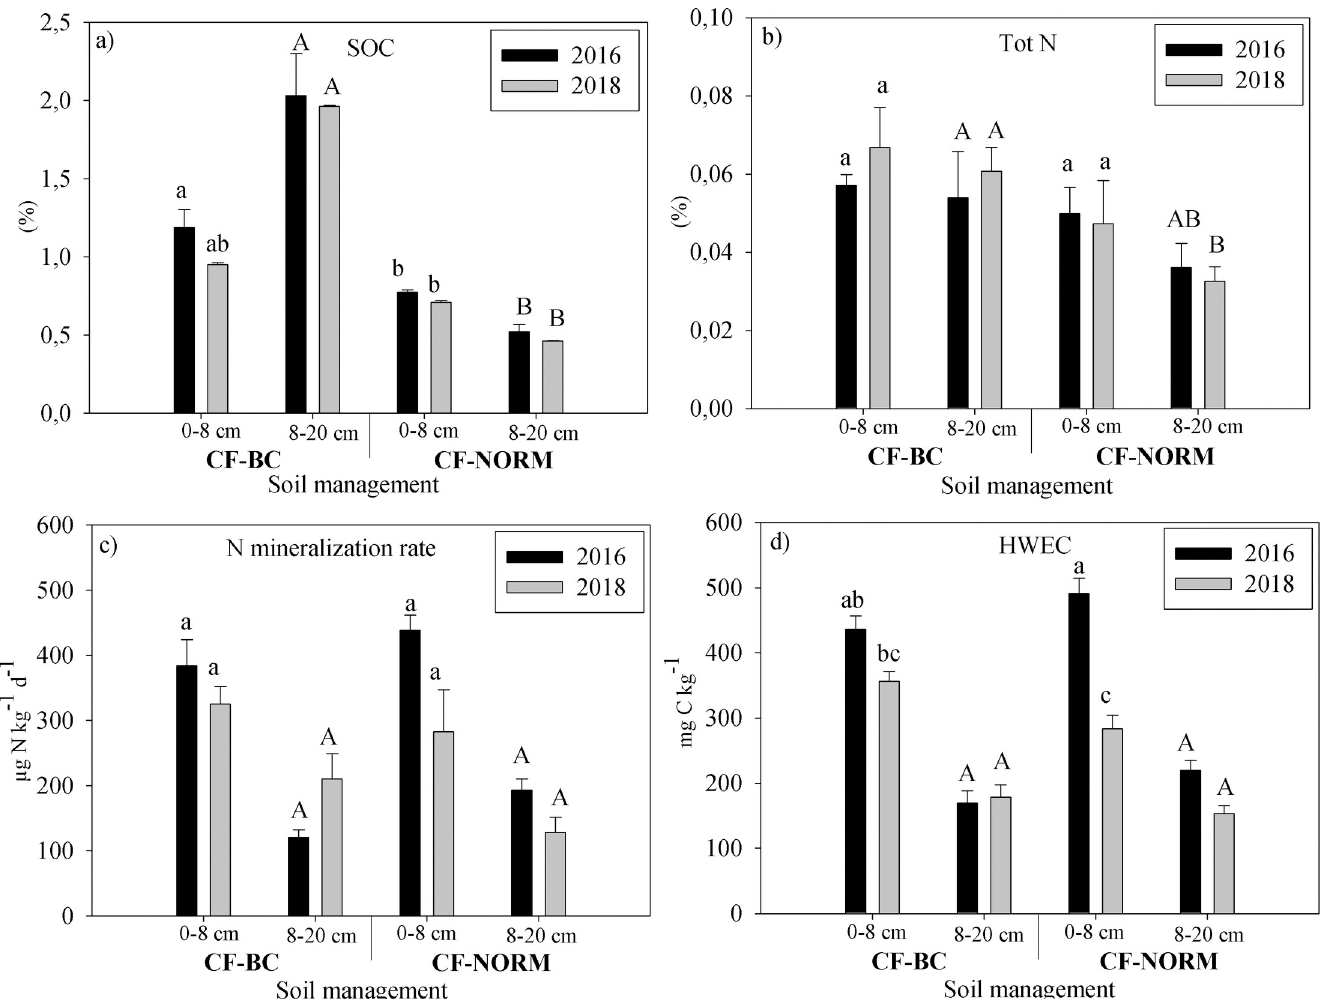
Fig 2. (a) SOC, (b) total N, (c) N mineralization rate and (d) HWEC inside planting basins in CF-NORM and CF-BC at 0 to 8 cm and 8 to 20 cm depth in 2016 and 2018. Lower case letters denote differences between treatments in 2016 and 2018 at 0 to 8 cm. Upper case letters show differences between treatments in 2016 and 2018 at 8 to 20 cm. Error bars represent standard errors, n =